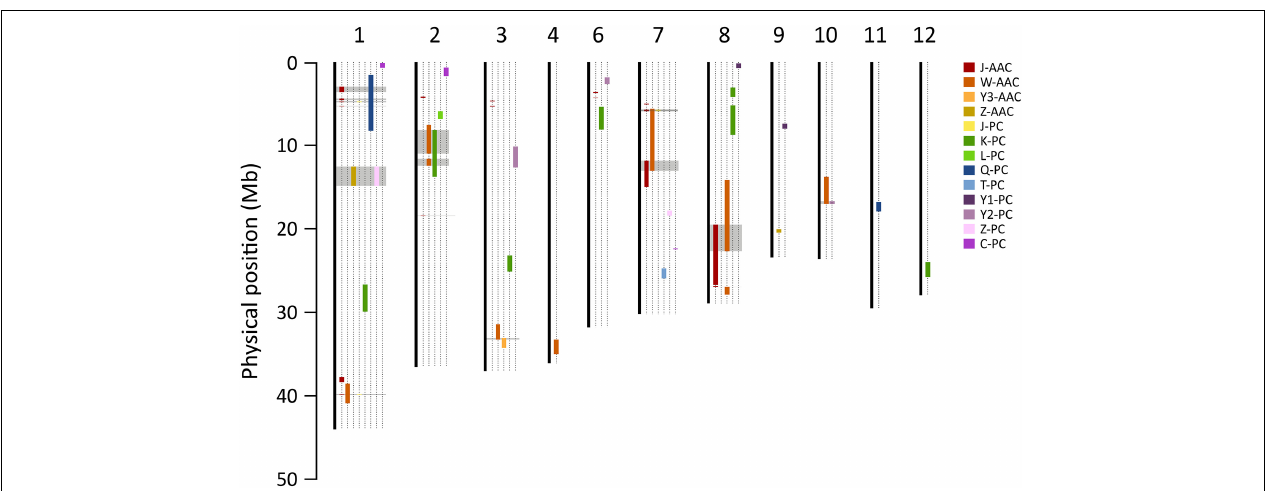
FIGURE 6 | Comparison of QTLs for PC and AAC in the present and previous studies. Color bars on chromosomes represent QTL regions for AAC and PC reported by the present and previous studies. Gray blocks indicate the loci where two more QTLs were co-located. Each prefix of trait indicates the previous study (J, this study; C, Chattopadhyay et al., 2019; K, Kinoshita et al., 2017; L, Lou et al., 2009; Q, Qin et al., 2009; T, Tan et al., 2001; W, Wang et al., 2007; Y1, Yun et al., 2014; Y2, Yu et al., 2009; Y3, Yoo, 2017; Z, Zhong et al.,